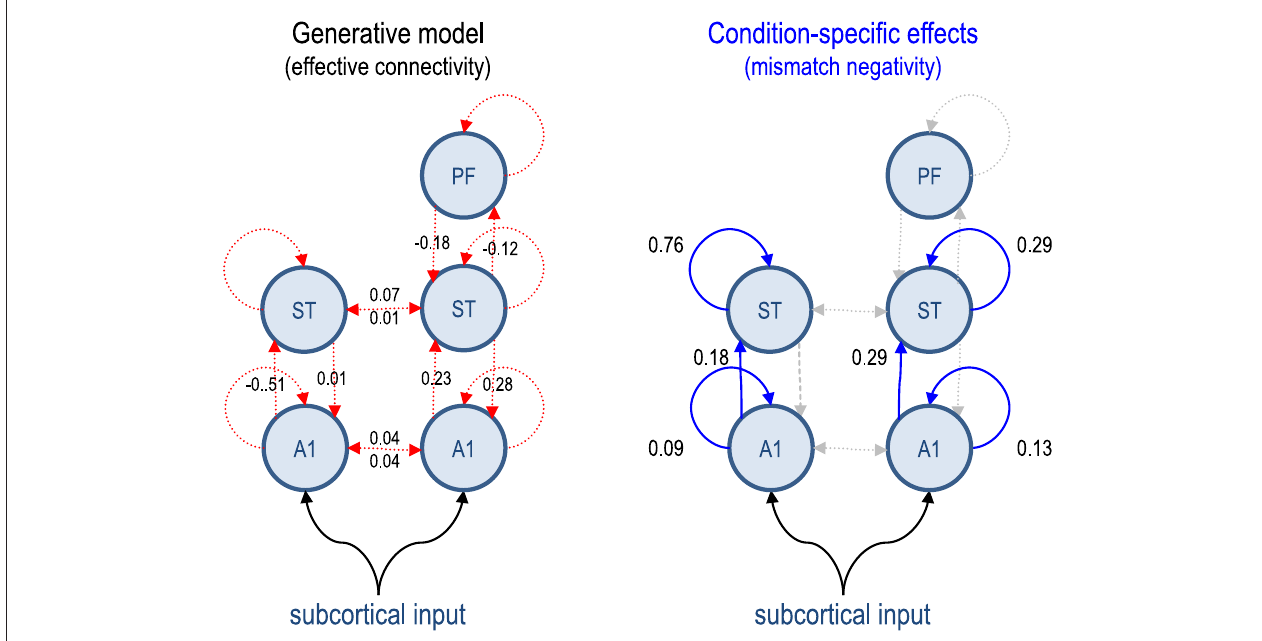
FIGURE 1 | This figure describes the generative model used to simulated data for subsequent model inversion and reduction. The circles represent electromagnetic sources of data (recorded by 128 sensors or channels). These sources have intrinsic dynamics, modeled with eight ordinary differential equations per source. The dynamics are perturbed with a parameterized exogenous (subcortical) input and coupled to each other through (effective) connections. Because the sources are organized hierarchically, one can refer to (between-source or extrinsic) connections as forward or backward. The strengths of these connections correspond to the key model parameters with random effects. The group averages (based on analysis of grand mean data from normal subjects) are shown alongside their connection: red connections (left panel) indicate connections that are common to both conditions, while blue connections (right panel) are equipped with parameters encoding condition-specific effects. The values are log scale parameters, therefore a negative value means a smaller (excitatory) connection strength. A1, primary auditory source; ST, superior temporal source; PF, prefrontal